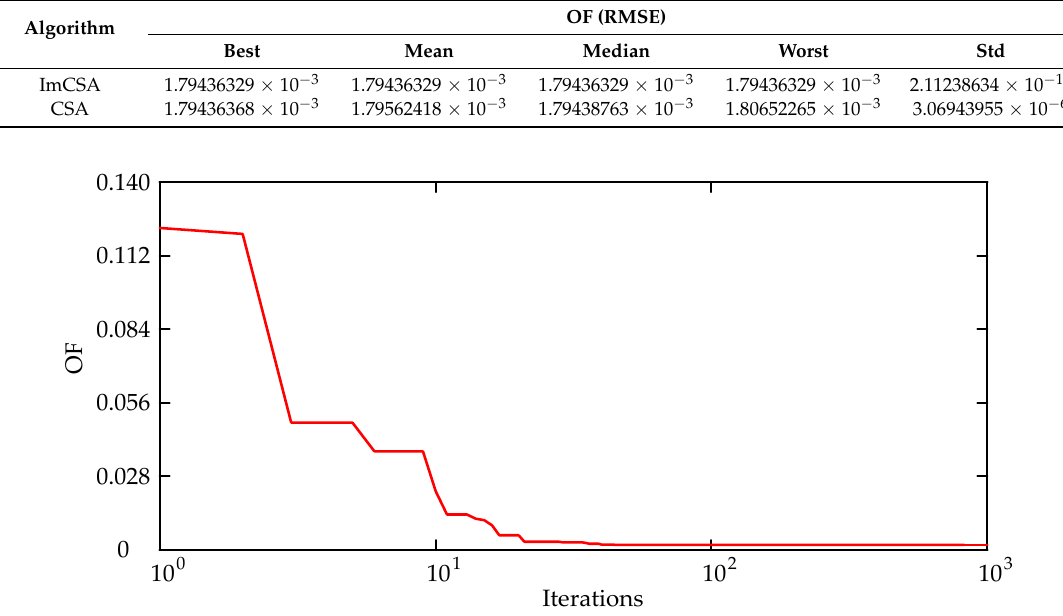
Table 13. Statistics of the OF (RMSE) values for the PMM of monocrystalline STM6-40/36 panel using the proposed ImCSA and CSA.